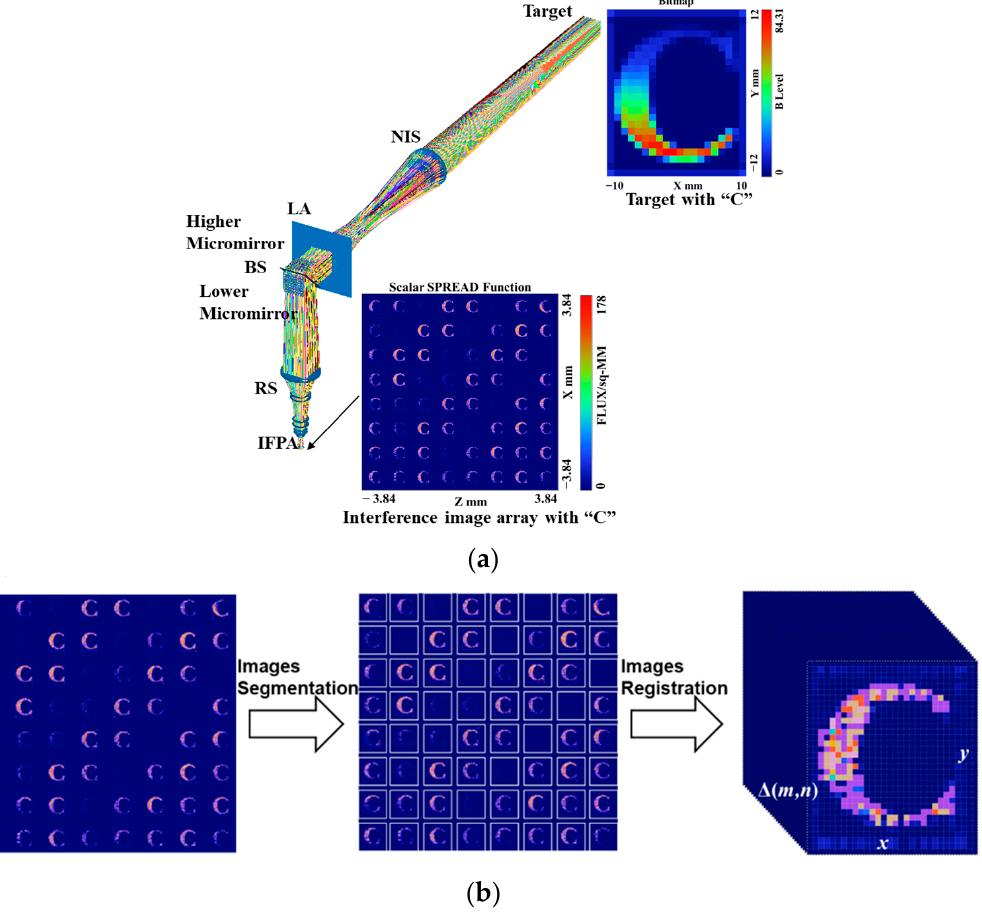
Figure 13. Physical simulation of SIIFTS: ( a ) SIIFTS light propagation diagram during physical simulation; ( b ) the processing of the interference image array from the physical simulation.